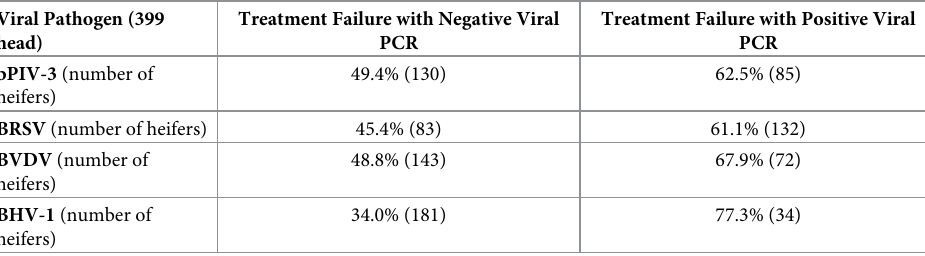
Table 7. Proportion of high-risk feeder heifers with treatment failure by viral multiplex PCR test.